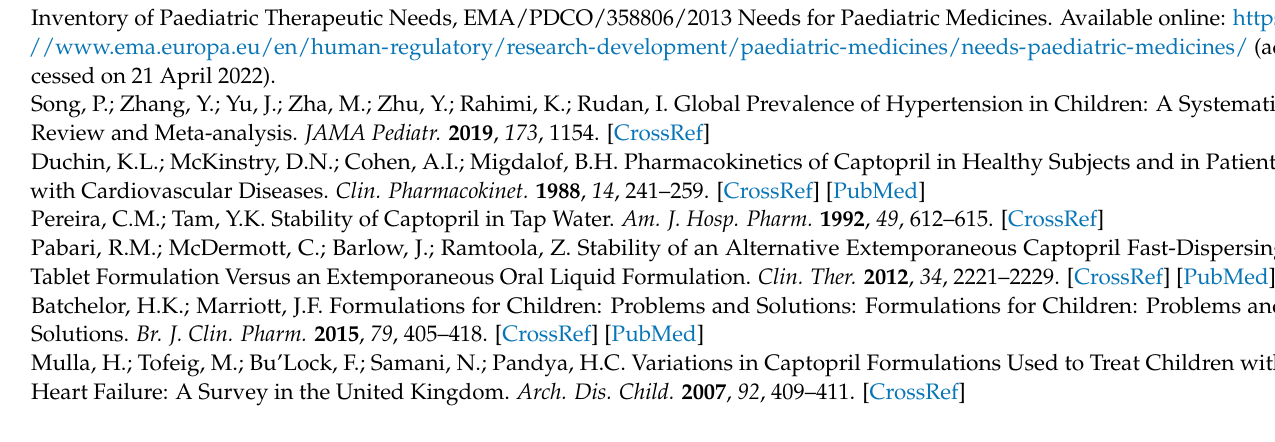
NPs. Figure S1: Influence of storage (4 ◦ C and 25 ◦ C) on mean diameter of NP-Cb (A) and NP-C (B) over 28 days ( n = 6). Figure S2: Influence of pH of dispersion media on particle size (A) and PDI (B) of NP-Cb and NP-C. Figure S3: In vitro cytotoxicity. Effect of free-CAT (100 µ M and 1000 µ M) on HFF-1 cells after and 48 h of